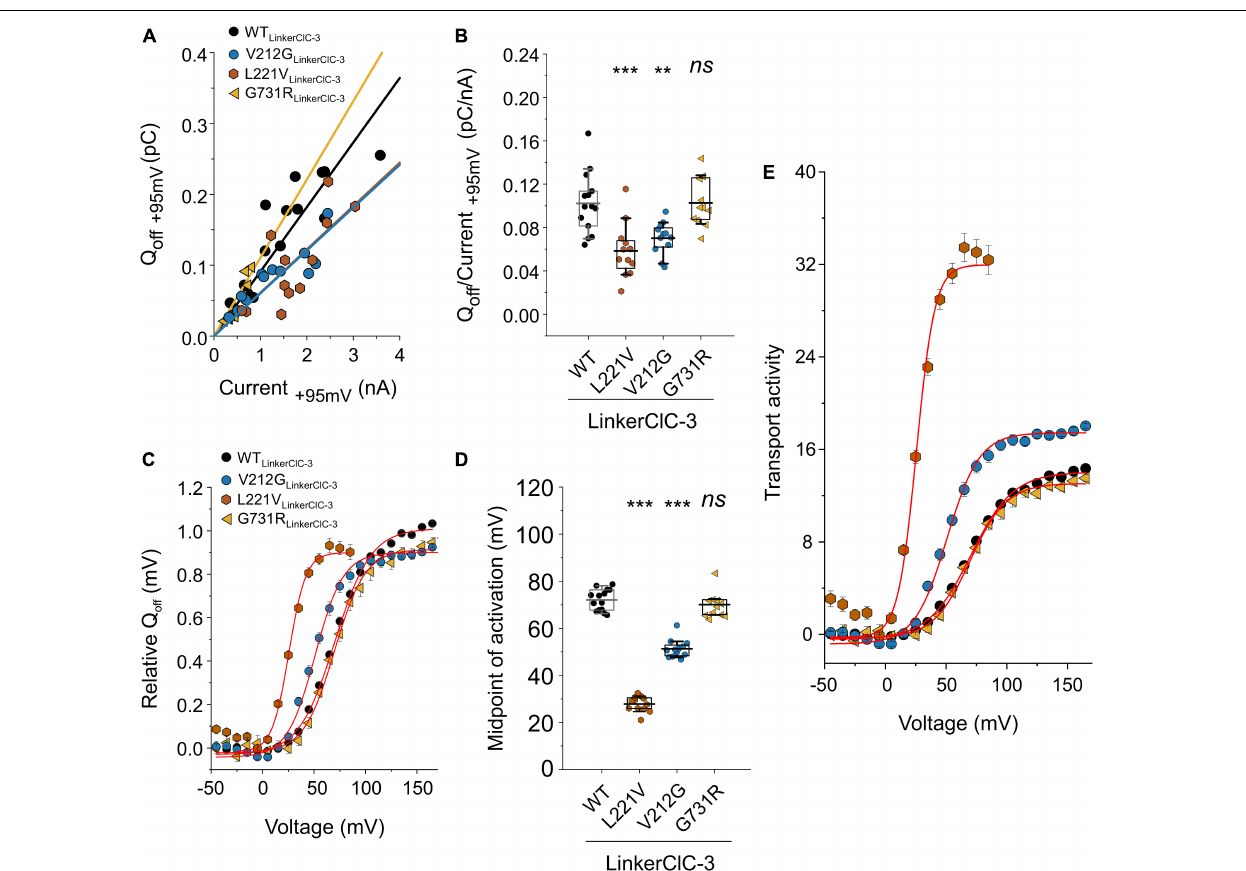
FIGURE 6 | Analysis of WT and mutant chimeric ClC-4 LinkerClC − 3 capacitive currents. (A) Plots of integrated capacitive current amplitudes at 0 mV ( Q off ) after a prepulse to +95 mV against transport current amplitudes at +95 mV for WT and mutant chimeric proteins. (B) Q off /current ratios for WT and mutant ClC-4 chimeric proteins. (C) ClC-4 activation curves constructed by plotting mean value ± s.e.m. of the normalized Q off against the preceding voltage. Solid lines show fits to single Boltzmann functions. (D) Mean values of activation midpoints ( V 0 . 5 ) obtained from Boltzmann fits to Q off - V relationship for WT and mutant chimeric transporters (WT, n = 14; V212G, n = 12; L221V, n = 12; and G731R, n = 11). (WT, n = 14; V212G, n = 12; L221V, n = 12; and G731R, n = 11). *** p < 0.001, **p < 0.01, and ns (not significant). (E) Transport activities of WT and mutant ClC-4 chimeric proteins calculated by dividing normalized Q off determined after various prepulses by Q off /current ratios shown in (B) . Mutant chimeric ClC-4 LinkerClC − 3 were compared with ClC-4 WT LinkerClC − 3 using one-way analysis of variance (with Tukey’s HSD post hoc testing). Data were obtained from four or five independent transfections and are presented as mean ± s.e.m. and boxplot boxes indicating upper and